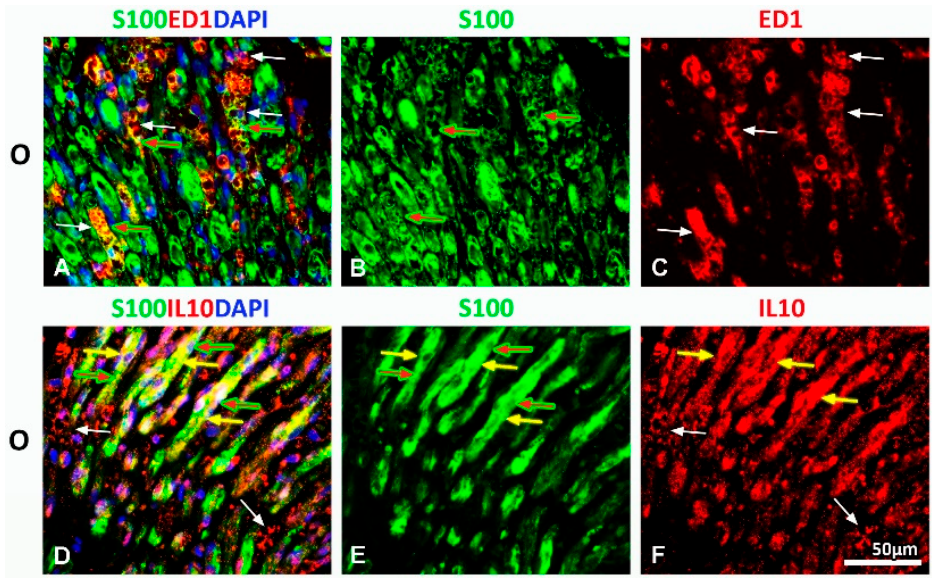
Figure 9. Interactions between M2 macrophages and SCs in injured femoral nerve. ( A – C ) We used double immunofluorescence to visualize the close contact between M2 macrophages and SCs at the 14th dpo. Serial transversal sections obtained from the operated (O) femoral nerve were immunostained for ED1 (anti-CD68, red) antibody, as a marker of activated macrophages ( C , white arrows), anti-S100 (green) antibody as a marker of SCs ( B , red arrows) and DAPI (blue) for visualizing cell nuclei. Complete overlapping ( A , yellow fluorescence) of ED1 (white arrows) and S100 (red arrows) immunoreactivity confirmed tight interactions between M2 macrophages and SCs that were aligned to form bands of Büngner. ( D – F ) Transversal sections of the operated (O) femoral nerve immunostained with S100 (green), IL10 (red) and DAPI (blue) demonstrated that M2 macrophages ( D , F , white arrows) and S100 + SCs ( E , red arrows) in bands of Büngner were intensively stained with IL-10 ( D , yellow arrows).